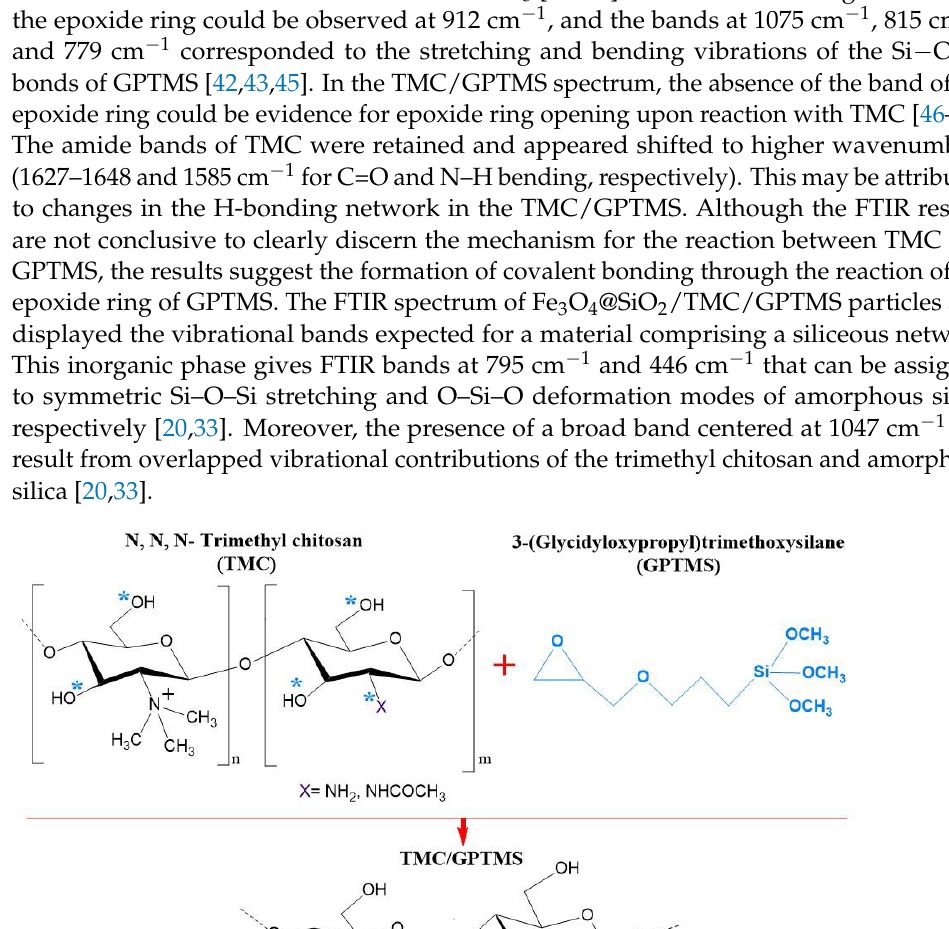
Table 1. Compositional and structural properties of the materials: elemental analysis, particle diam- eter, BET surface area, and pore volume.